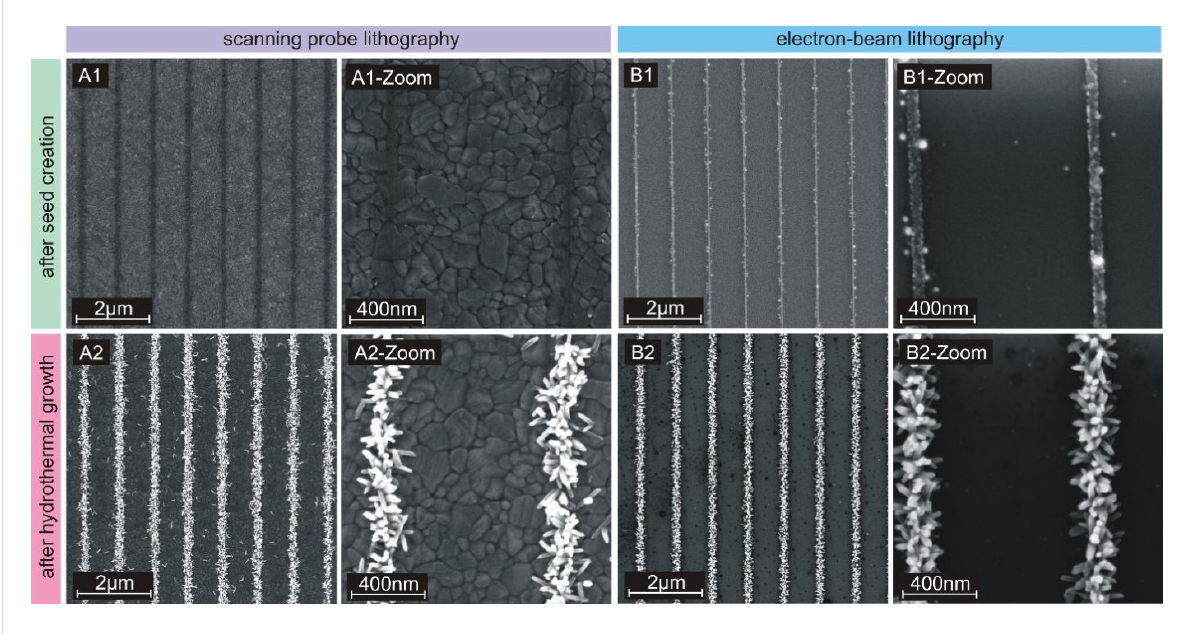
Figure 2: SEM images with different magnifications after scratching (panel A1, using scanning probe lithography) and seed fabrication (panel B1, using electron-beam lithography), and before hydrothermal growth; line array consisting of nanorods created with the hydrothermal growth process (panel A2 and panel B2 for scanning probe and electron-beam lithography, respectively). The stripe width is less than 100 nm, the pitch is 1 μ m and the rod length is approximately 100 nm. B1- and B2-Zoom are reprinted with permission from our previous work [36], copyright 2018